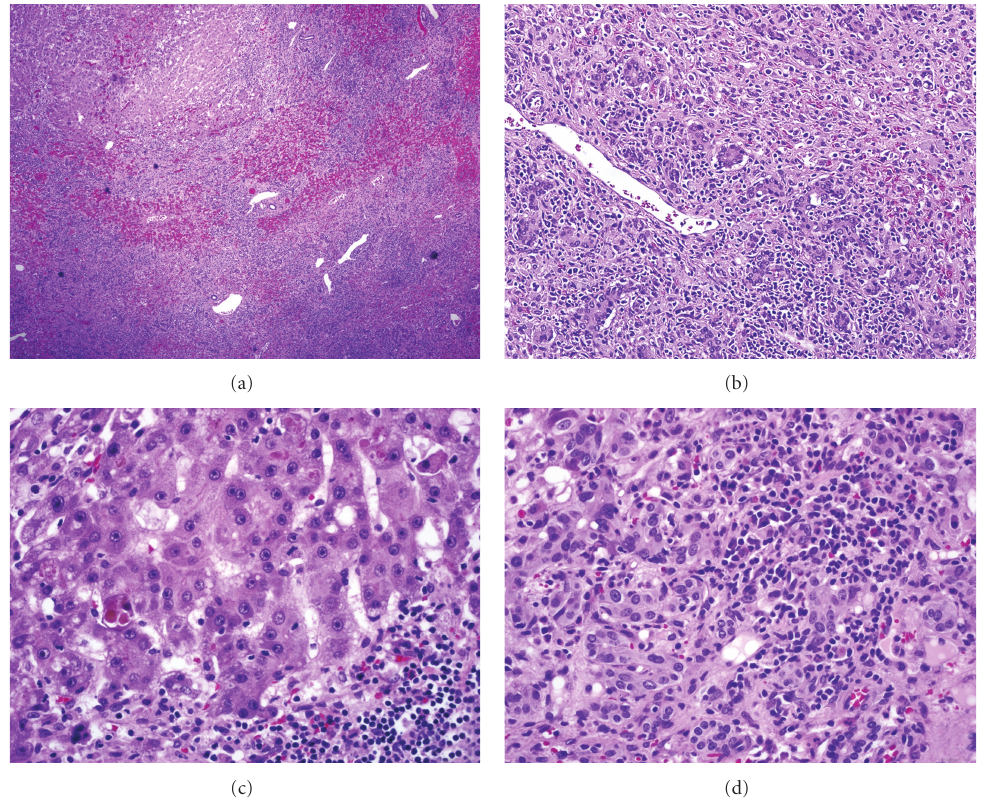
Figure 1: (a) Submassive confluent necrosis with hemorrhage (H & E, 40x). (b) Periportal bile duct proliferation and mixed inflammatory infiltrate (H&E, 100x). (c) Residual hepatocytes with cholestasis, acidophilic bodies, and mononuclear inflammation (H&E, 400x). (d) Eosinophilic and lymphoplasmacytic infiltrate (H&E,